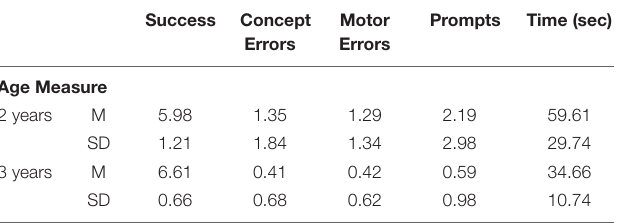
TABLE 2 | Means and standard deviations of children’s performance on the wooden puzzle pre-test by age and